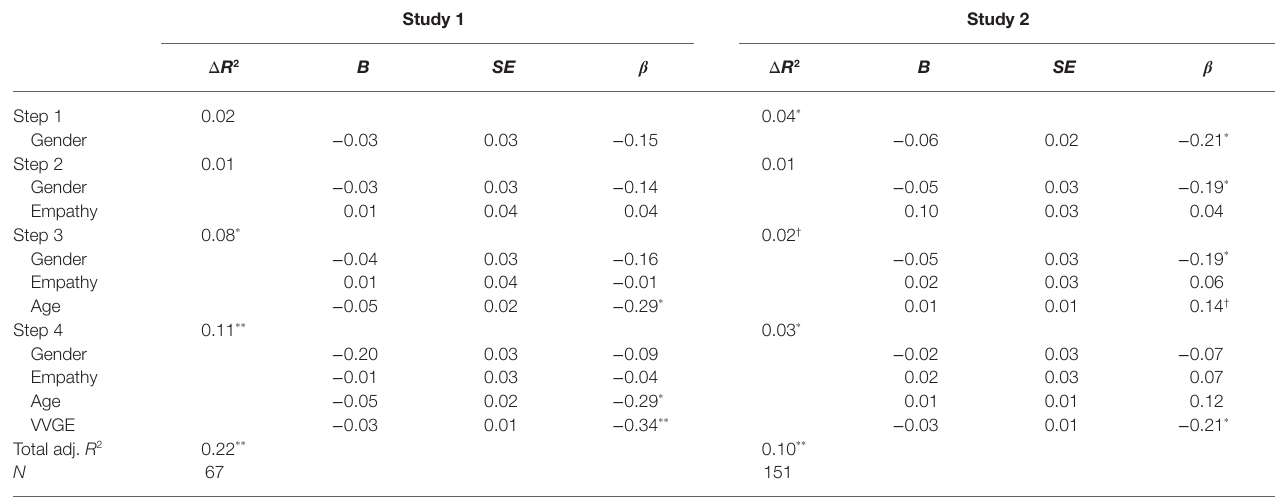
TABLE 2 | Hierarchical multiple regression analyses predicting correctness of facial expression recognition as measured with the FEMT in Study 1 and Study